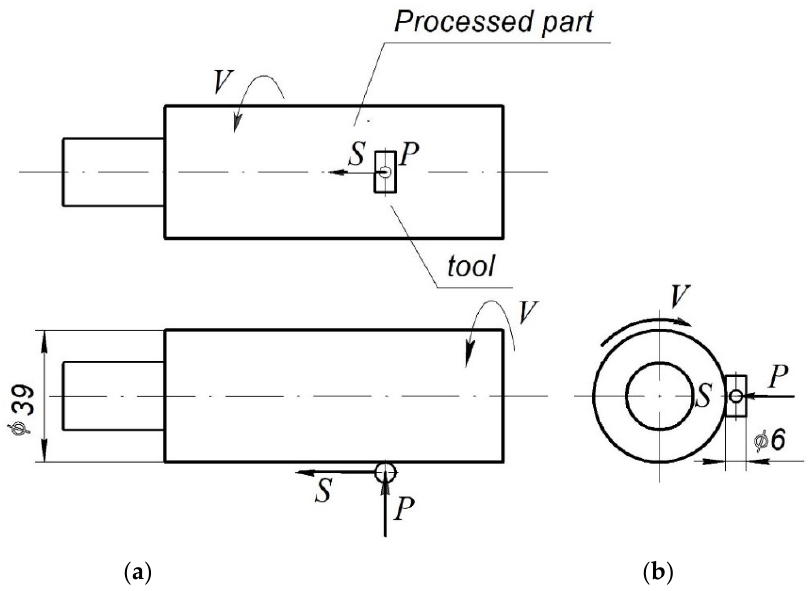
Figure 1. Schematic illustration of the burnishing process: ( a ) side view; ( b ) front view. The following